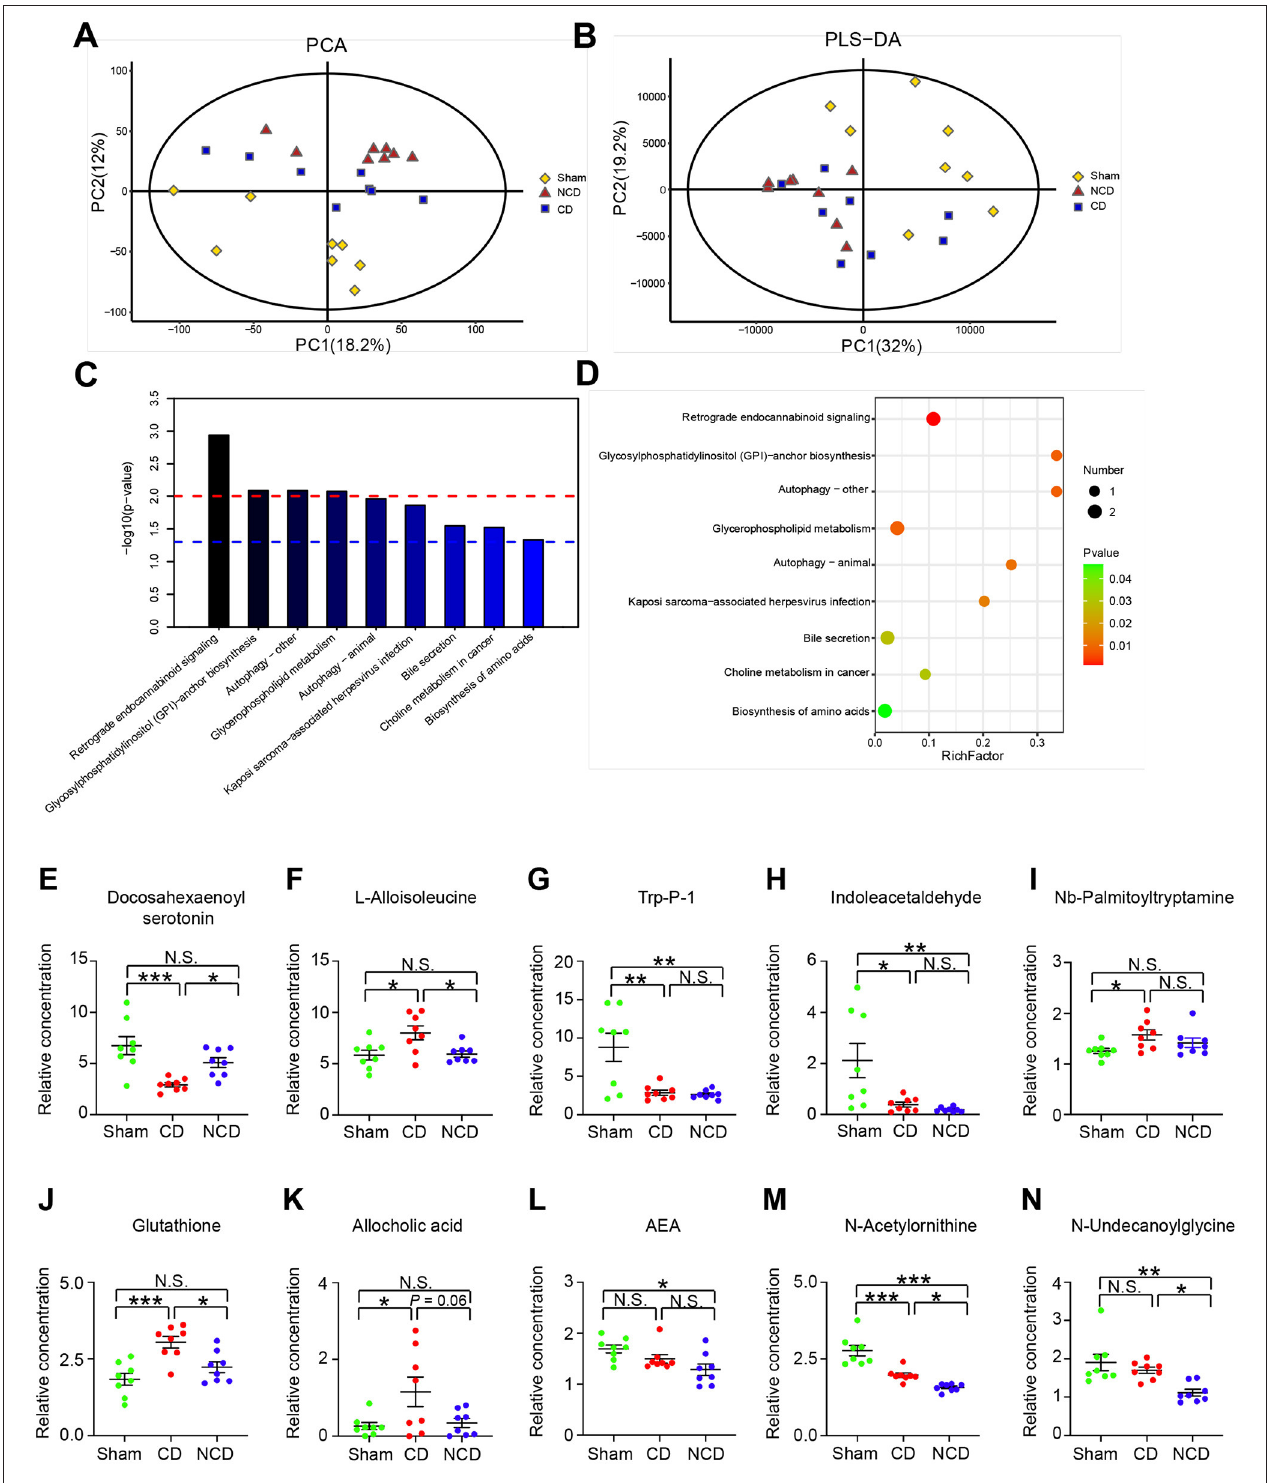
FIGURE 4 | Metabolic profiling analysis among the groups. (A) Principal component analysis (PCA). (B) The partial least squares discriminant analysis (PLS-DA) of plasma metabolites. (C) The Kyoto Encyclopedia of Genes and Genomes (KEGG) pathway analysis of differentially expressed metabolites. Y-axis shows the P -value of a particular pathway. (D) Enriched KEGG pathways in plasma metabolites. Rich factor indicates the ratio of differentially expressed metabolites to the total metabolites